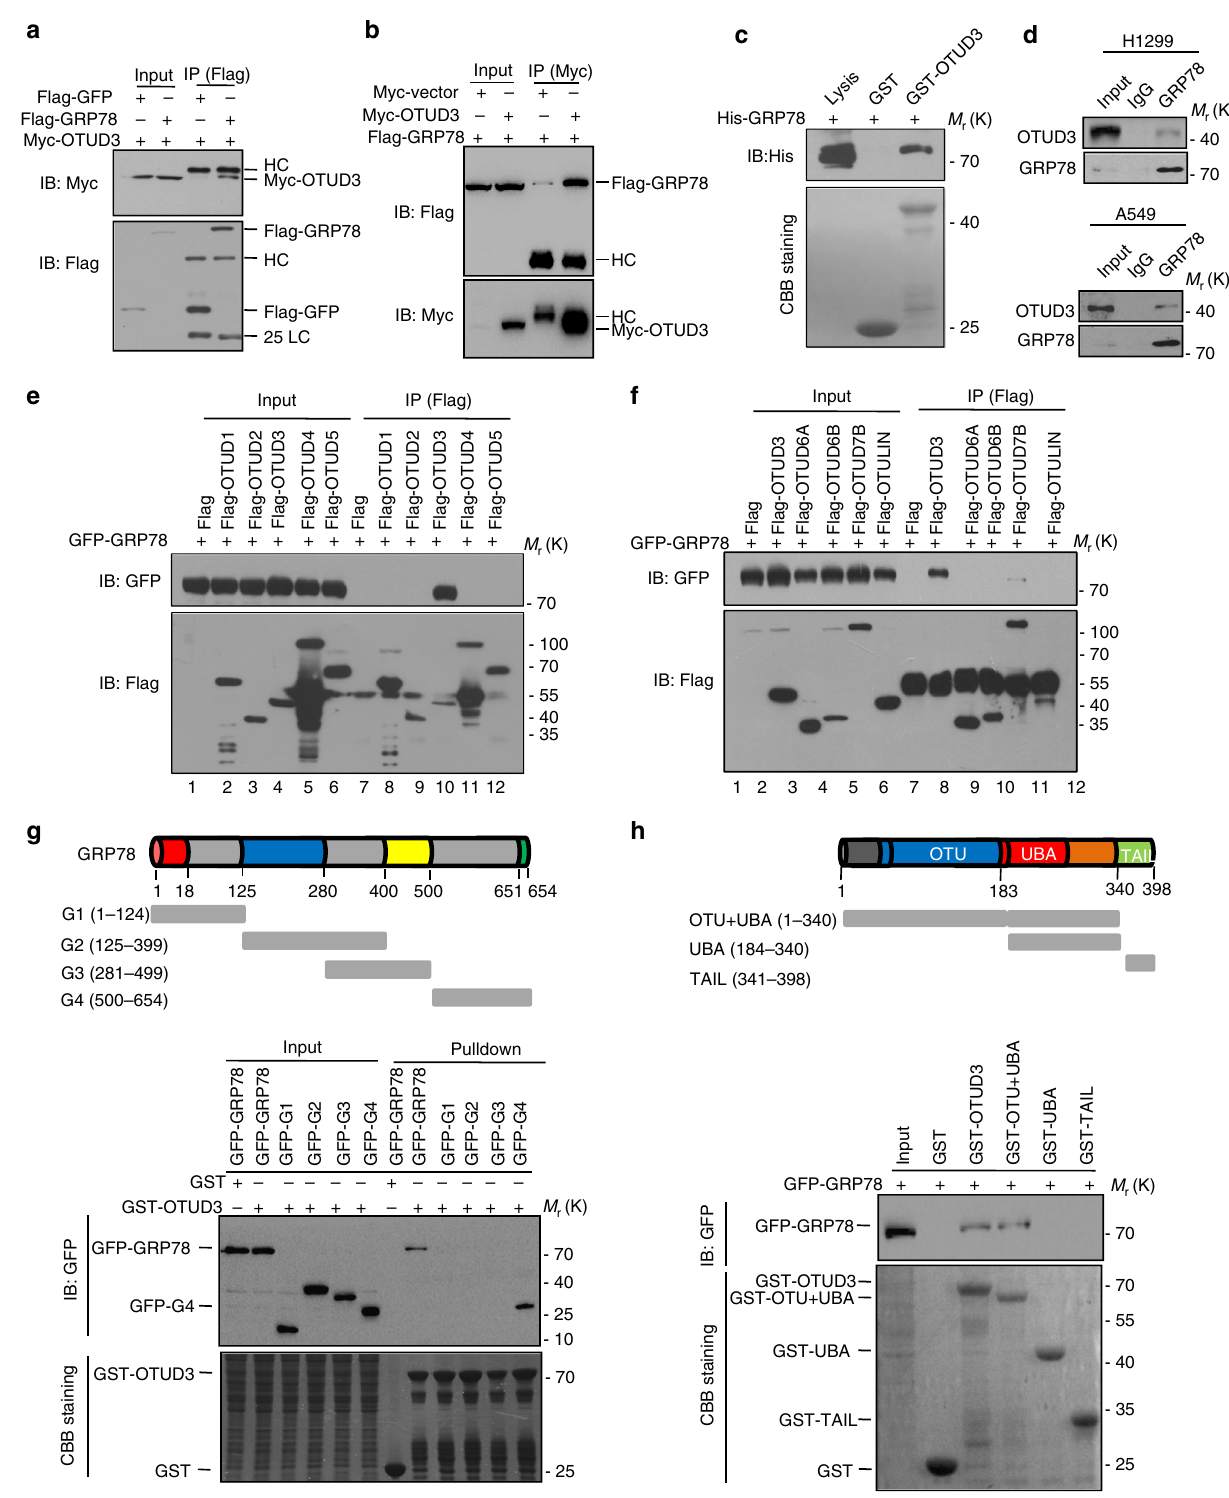
Fig. 5 OTUD3 directly interacts with GRP78. a , b Flag-GRP78 and Myc-OTUD3 were co-transfected into HEK293T cells. The cell lysates were subjected to immunoprecipitation (IP) with anti-Myc or anti-Flag antibodies. c GST pull-down assays were performed to indicate the direct interaction between OTUD3 and GRP78. d H1299 and A549 cell lysates were subjected to immunoprecipitation with control IgG or anti-GRP78 antibody. The immunoprecipitates were then detected using the indicated antibodies. e , f HEK293T cells transfected with the indicated Flag – DUBs were subjected to immunoprecipitation (IP) with anti-Flag antibodies. The lysates and immunoprecipitates were analyzed. g Schematic illustration of GRP78 structure. HEK293T cells transfected with the indicated constructs were subject to GST pull-down. The proteins retained on Sepharose were blotted with the GFP antibody. h Schematic illustration of OTUD3 structure. HEK293T cells transfected with GFP-GRP78 were subjected to GST pull-down. The proteins retained on Sepharose were blotted with the GFP antibody. For all panels, results are representative of three independent experiments. Uncropped images of blots are shown in Supplementary Fig.